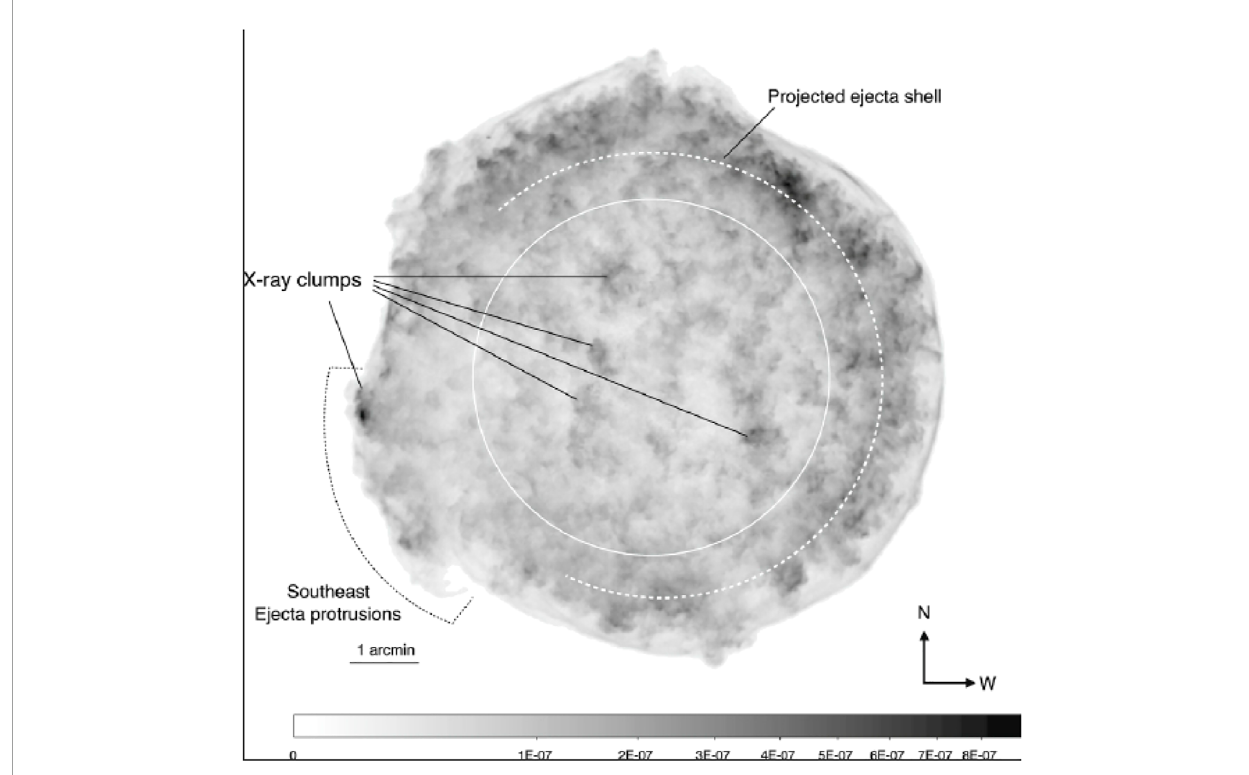
FIGURE 6 Figure 2 in Sato et al. (2019). Flux image (1.76–4.2 keV) of Tycho’s SNR observed in 2009 by Chandra. The central region (inner white circle) of the remnant has been used for the genus statistics. The southeast ejecta protusions can be seen as well in the Figure. Courtesy of J.P. Hughes. © AAS. Reproduced with